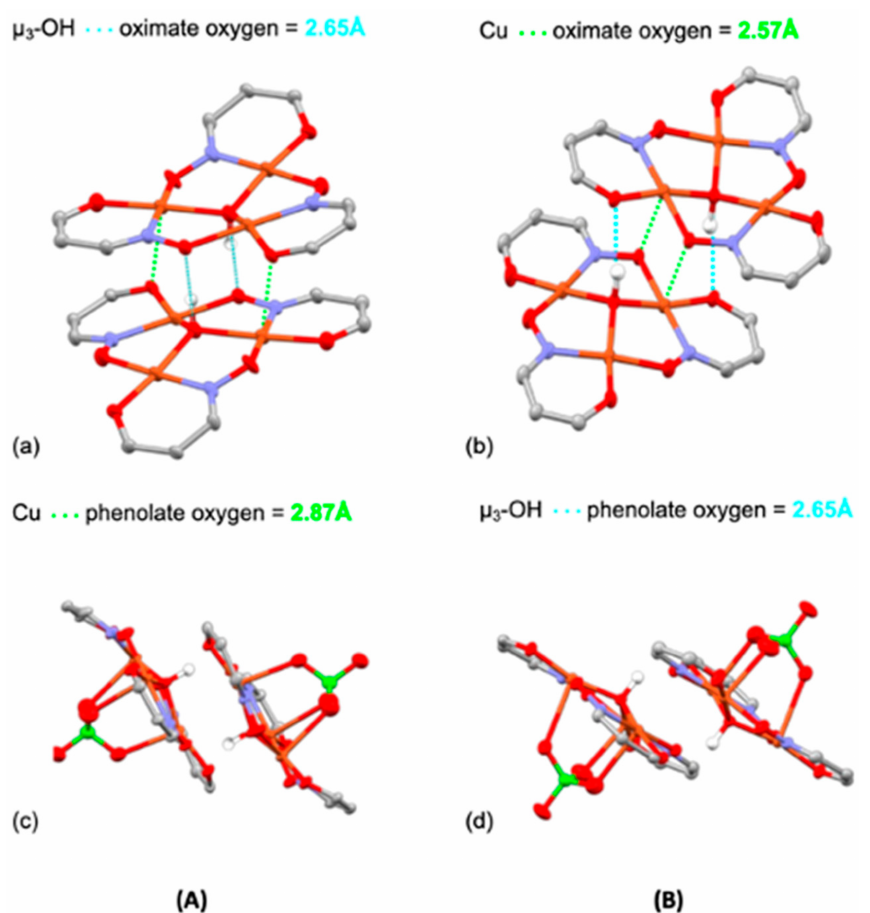
Figure 14. The central Cu-chelating units of forms ( A , B ) of the hexanuclear complexes {[Cu 3 OH( L 9 H) 3 (ClO 4 )](ClO 4 )} 2 .1.5H 2 O and {[Cu 3 OH( L 9 H) 3 (ClO 4 )](ClO 4 )} 2 .11H 2 O.MeCN show- ing the secondary bonding which creates the dimeric structures. The shortest Cu ... O contact distances and the O ... O distances associated with hydrogen bonds formed by the µ 3 -OH groups listed are marked. The pendant piperidinium groups have been removed for